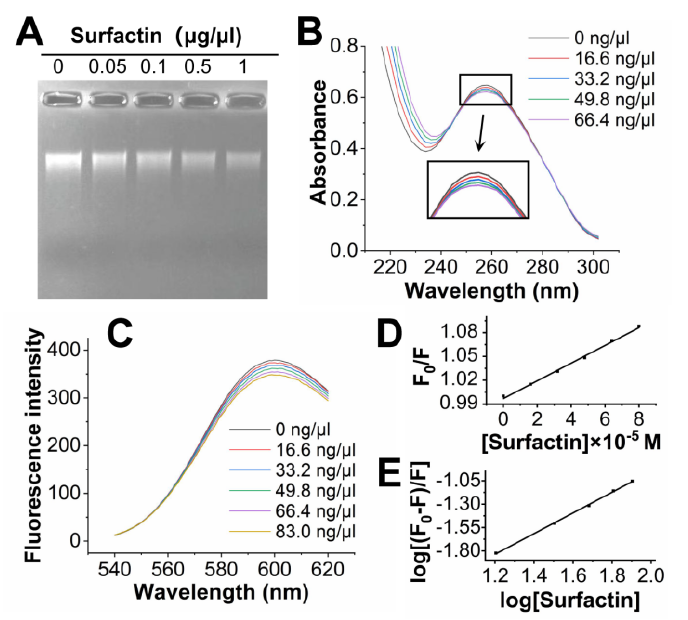
Figure 7. The interaction between surfactin and the genomic DNA of F. foetens . ( A ) Gel retardation assay after surfactin mixed with the DNA. ( B ) UV-Visible absorption spectra of F. foetens DNA with increasing concentrations of surfactin in PBS buffer (pH = 7.2). ( C ) The effect of surfactin on the fluorescence emission of ff-DNA-EB complex ( λ ex = 485 nm). ( D ) The Stern-Volmer plot of surfactin quenching effect on ff-DNA-EB complex fluorescence at room temperature. ( E ) The double-log plot of surfactin quenching effect on ff − DNA − EB complex fluorescence at room temperature.